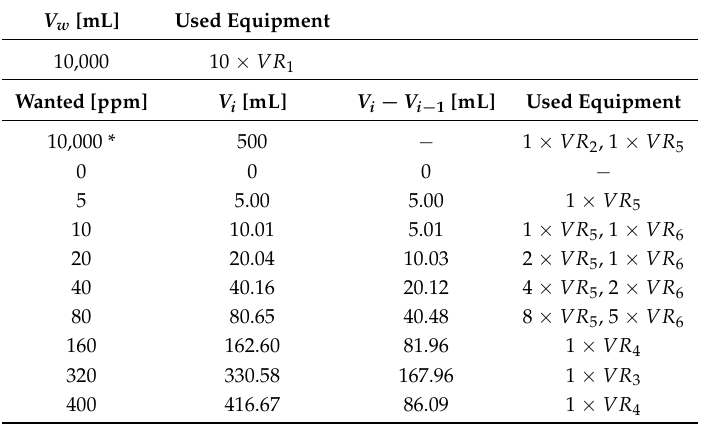
Table 7. A list of used equipment used for mixing each concentration, V i − V i − 1 represent the amount of stock solution that should be added to reach the target